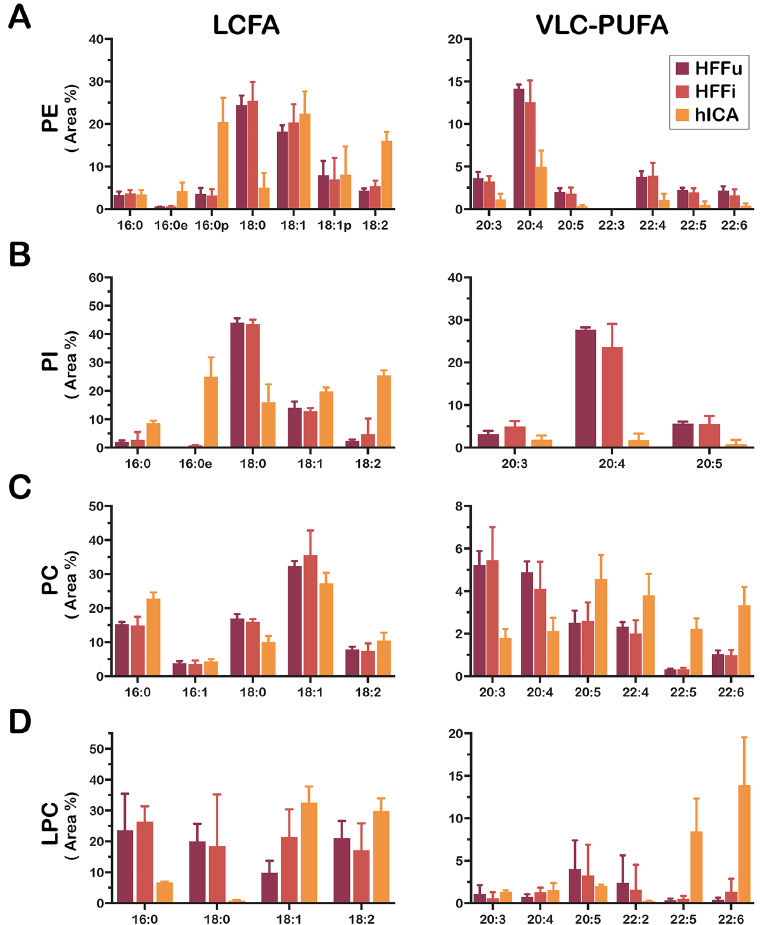
Fig 4. Trends in host and parasite FA composition varies between lipid classes. The relative proportion of identified FA for (A) PE, (B) PI, (C) PC, and (D) LPC lipid subclasses is plotted (FA area %; calculated as detailed in Methods) for HFF-derived samples (C2C12-derived samples plotted in S4 Fig): uninfected HFF ( HFFu ), T . cruzi -infected HFF (HFFi ) and T . cruzi amastigotes purified from HFF ( hICA ).The long-chain fatty acid (LCFA) and very long-chain polyunsaturated fatty acid (VLC-PUFA) are plotted separately for clarity. Data are represented as mean ± standard